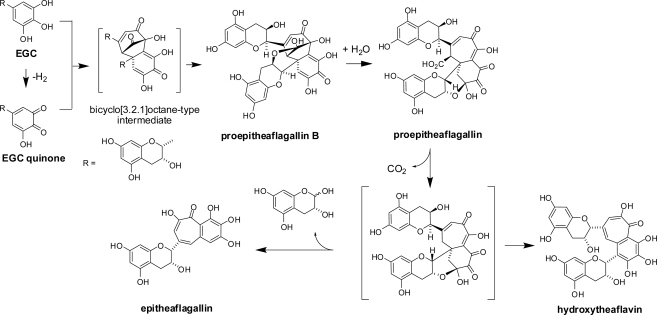
Production and decomposition of proepitheaflagallin [38,40].